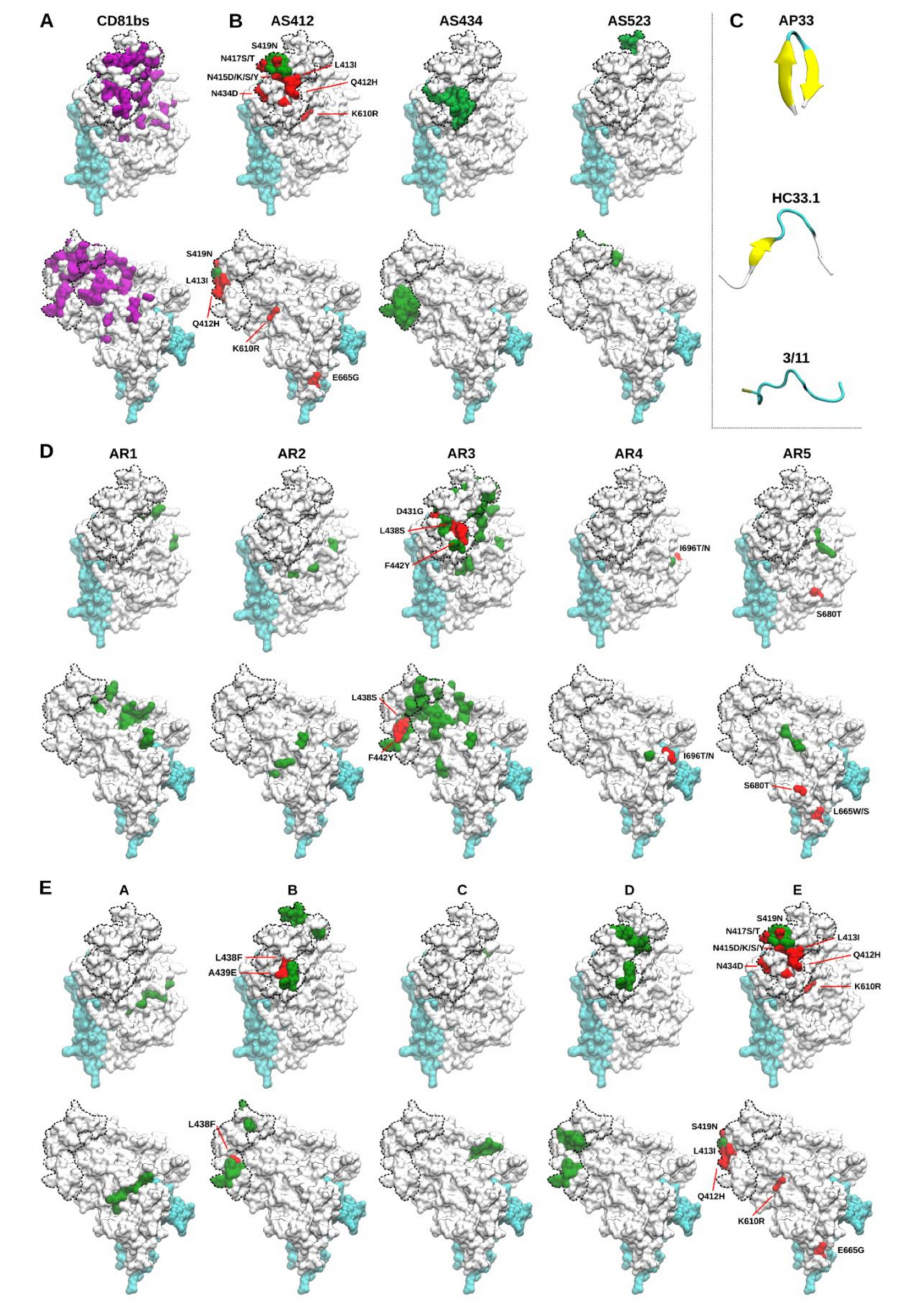
Figure 2. Structural mapping of E1/E2 CD81bs, epitope clusters, and escape mutations. ( A ) Residues participating or affecting the binding to CD81 according to Gopal et al. 2017 [47] are represented